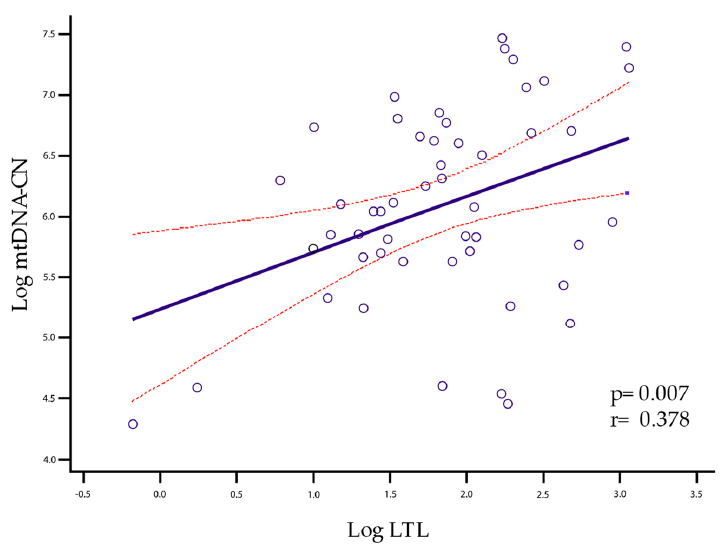
Figure 3. Linear correlation between LTL and mtDNA-CN was significant for the mild-moderate group ( p = 0.007, r = 0.378). The solid line represents the regression line, and the dashed lines represent the confidence interval of 95%.